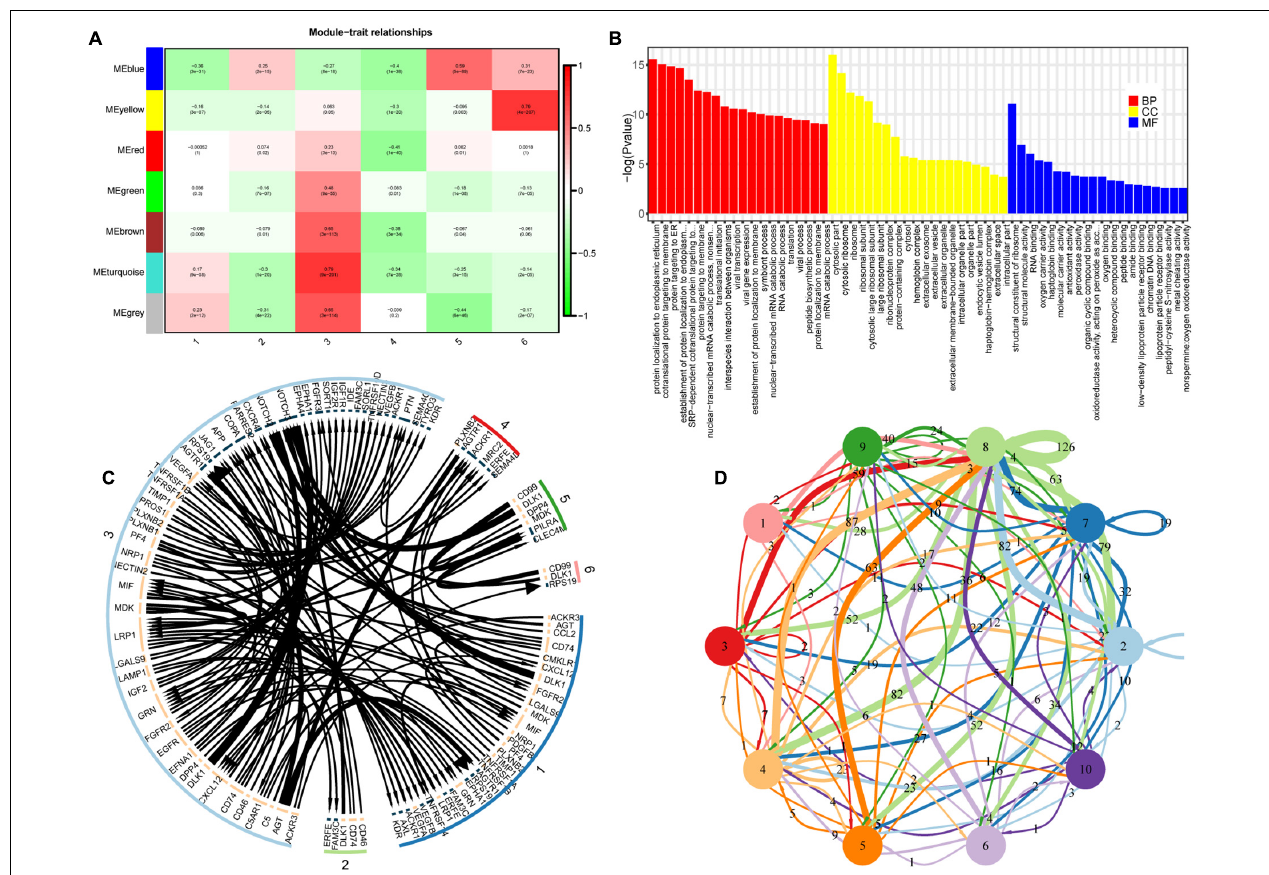
FIGURE 7 | Co-expression networks analysis and cellular communication analysis of the cell clusters in embryonic liver. (A) The hierarchical clustering tree shows each co-expression modules in the 8 PCW liver. (B) The heatmap shows the Spearman correlation of co-expression modules in the 8 PCW liver, (C,D) Cellular communication analysis of the cell clusters in the 8 PCW liver and 17 PCW liver. PCW, post-conception